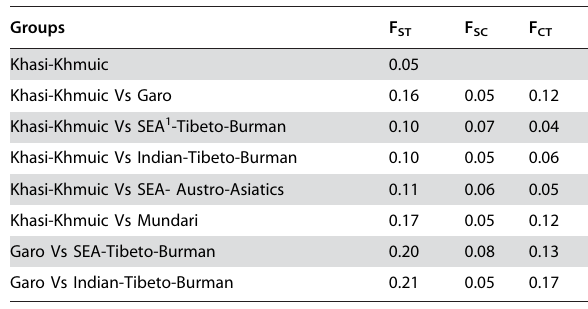
Table 4. Analysis of Molecular Variance using mtDNA haplogroups between groups of populations categorized